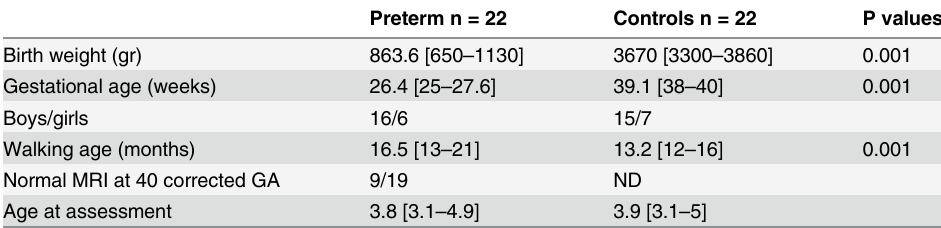
Table 1. Clinical characteristics of children